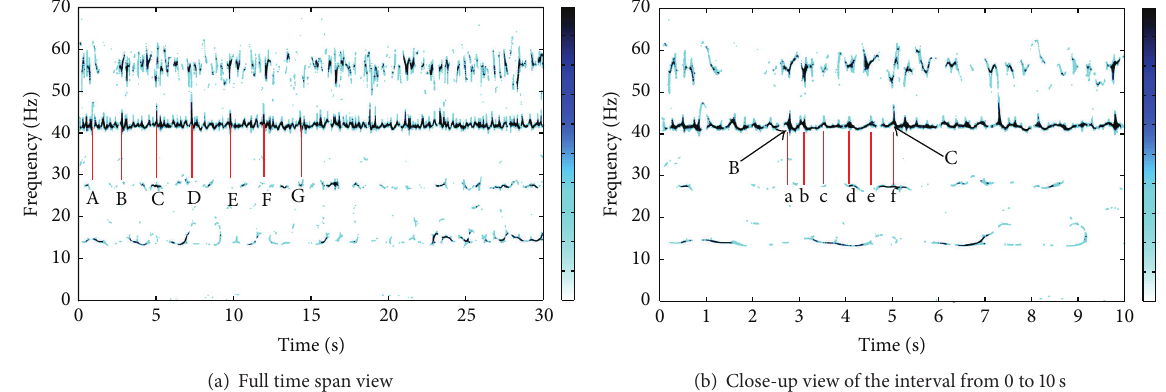
Figure 14: Reassigned scalogram of faulty